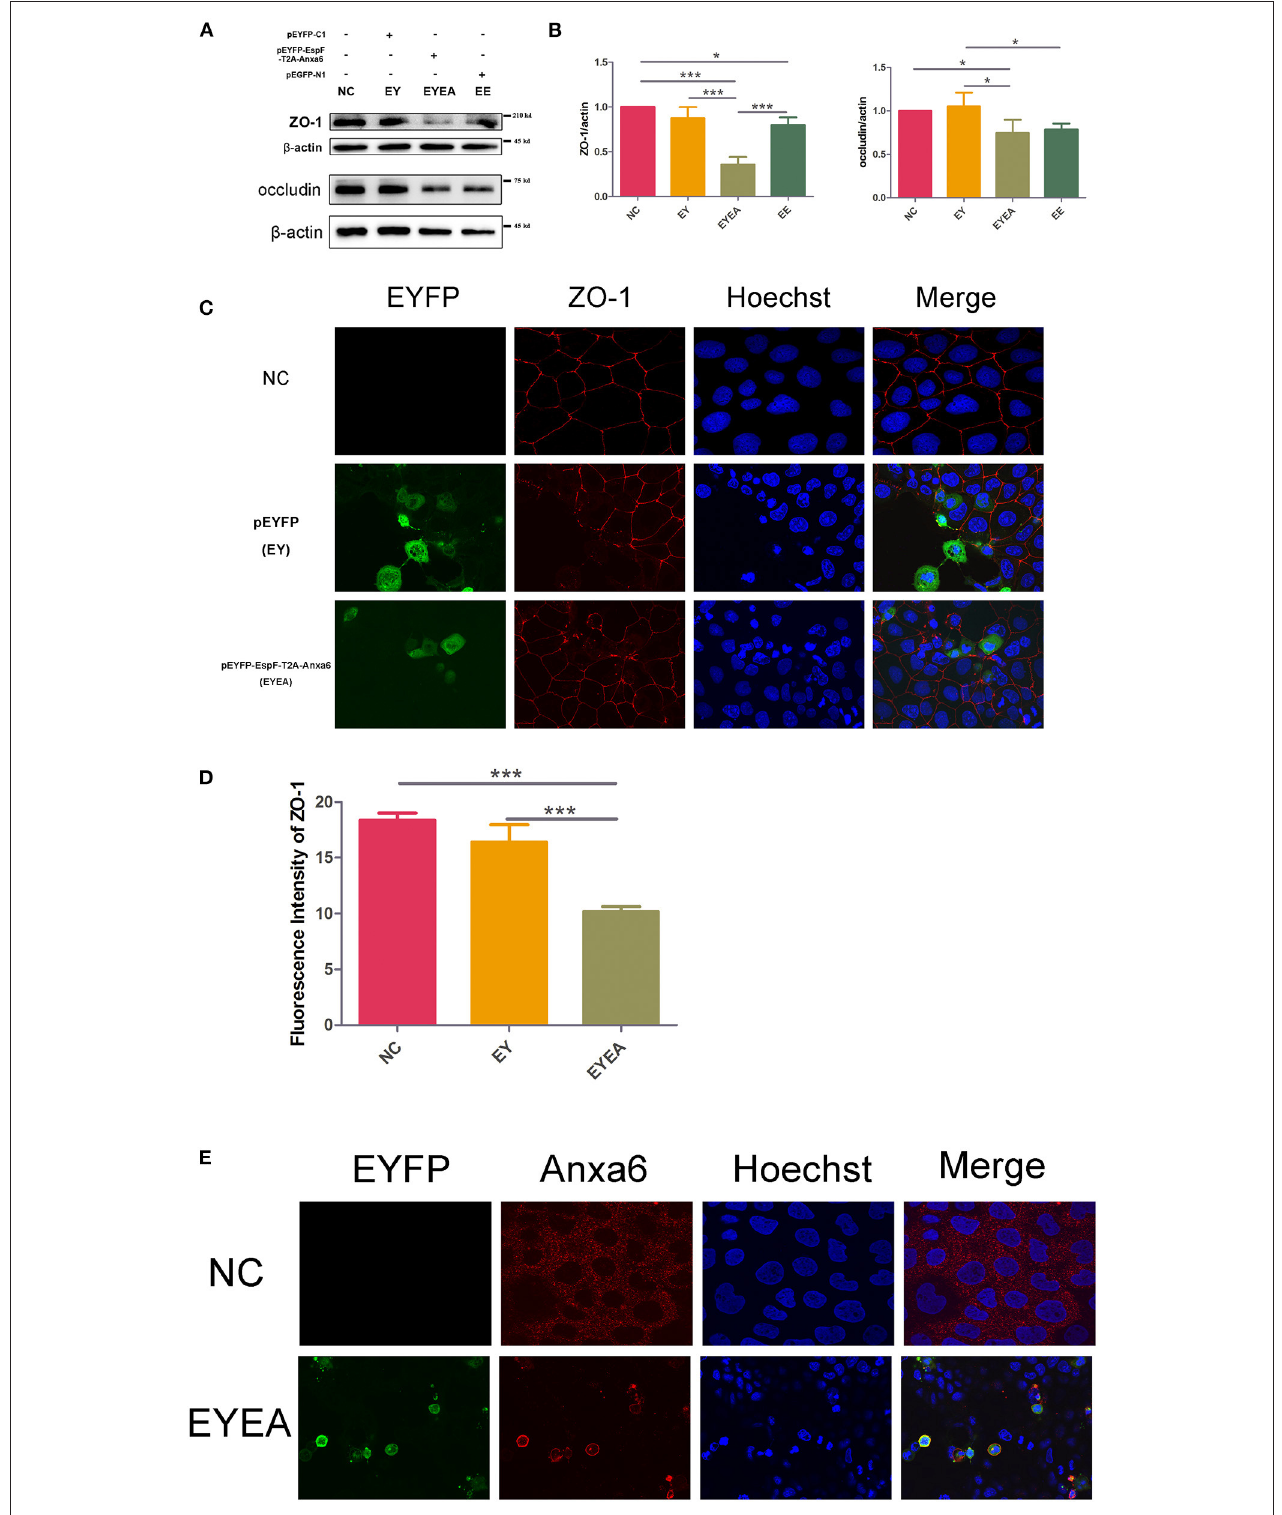
FIGURE 5 | The co-expression of EspF and ANXA6 protein in Caco-2 cells reduced the level of ZO-1 and occludin and disrupted the structure of ZO-1. (A,B) The expression levels and grayscale analysis of WB strips in Caco-2 cells transfected with plasmids as indicated. The grayscale analysis was performed in ImageJ